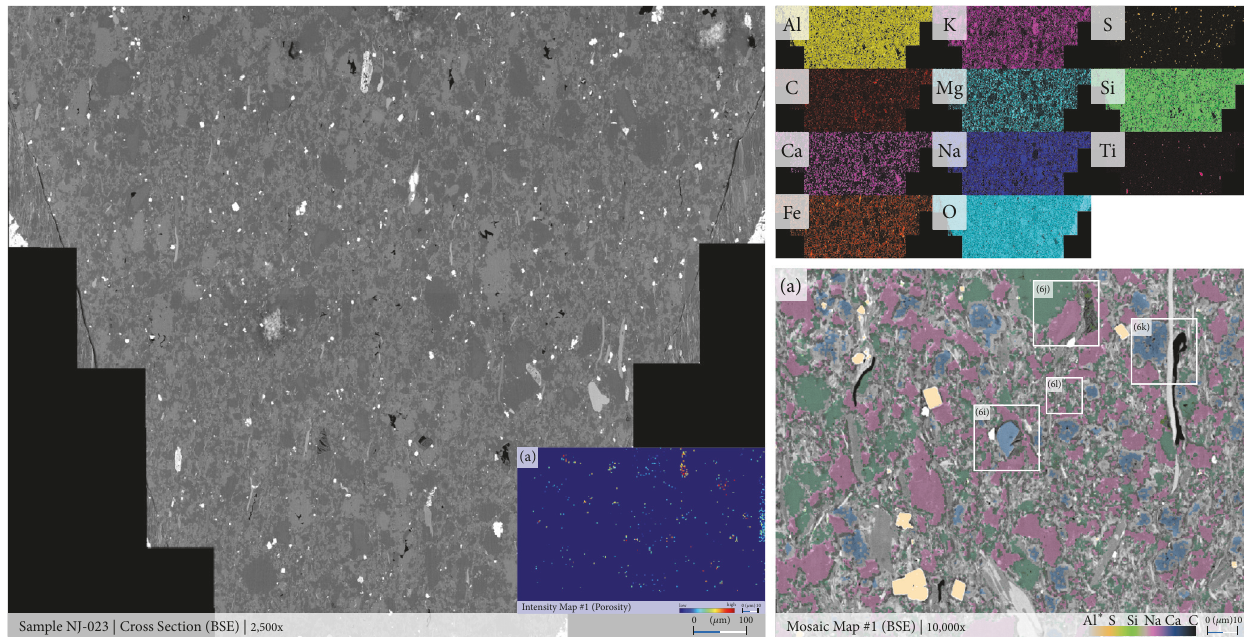
Sample NJ-023 | Cross Section (BSE) | 2,500x Figure 5: BIB-SEM investigation of sample NJ-023 including local porosity map and selected areas of interest depicted in Figure 6. Due to very narrow milling results, the exact location of NJ-023’s high-resolution map cannot be indicated within the illustrated cross-section of this sample as it was imaged approx. 2 mm besides in another proximal